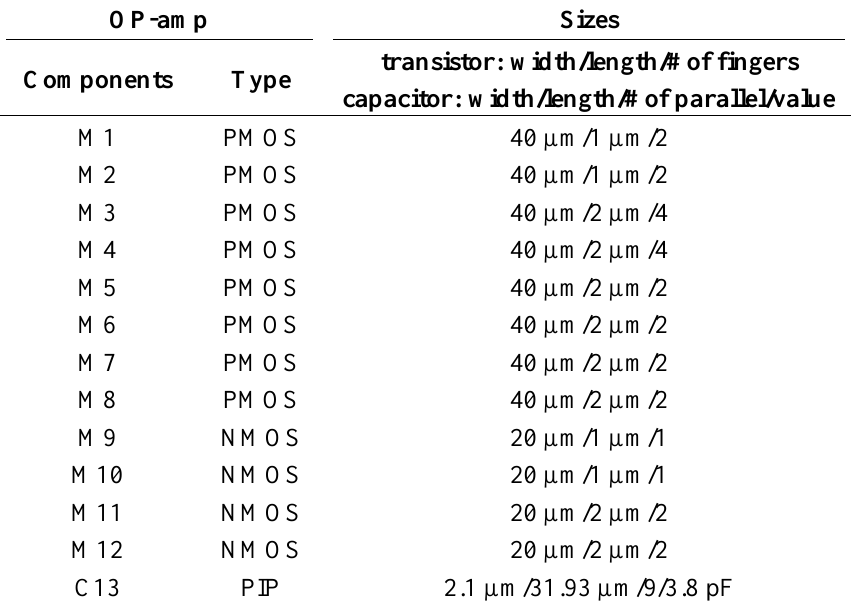
Table 1. Device sizes used in Figure